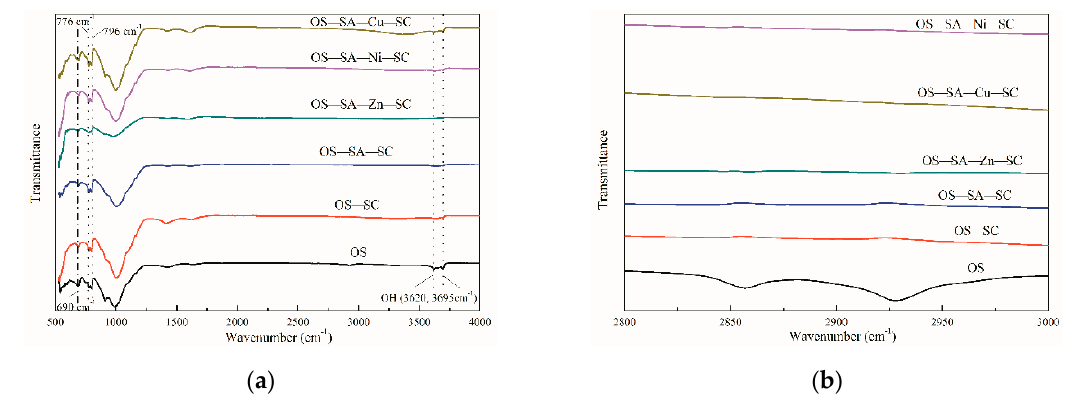
Figure 6. FTIR spectra of OS and SC ( a ) without catalyst and ( b ) with catalyst.